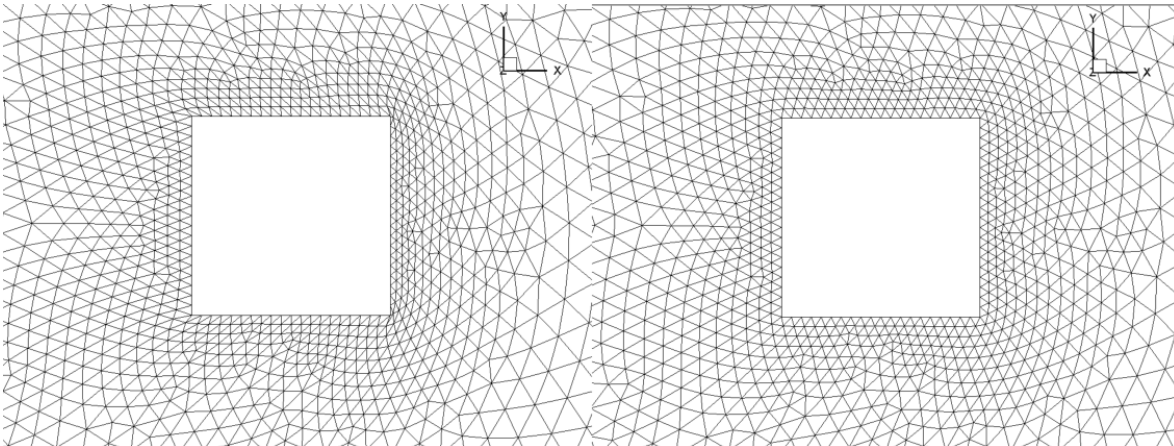
Figure 4. Comparison of the ground deformation for the same displacement using pseudo-solid ( left ) and RBF ( right ) [42].